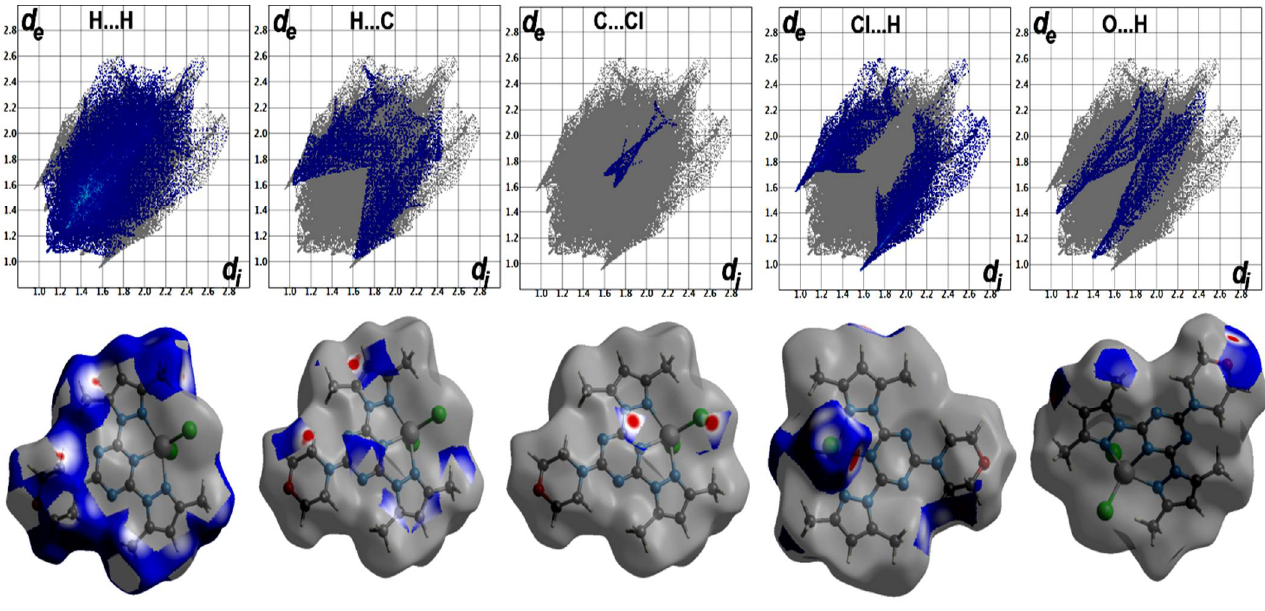
Figure 7. Hirshfeld surfaces of complex 1 .